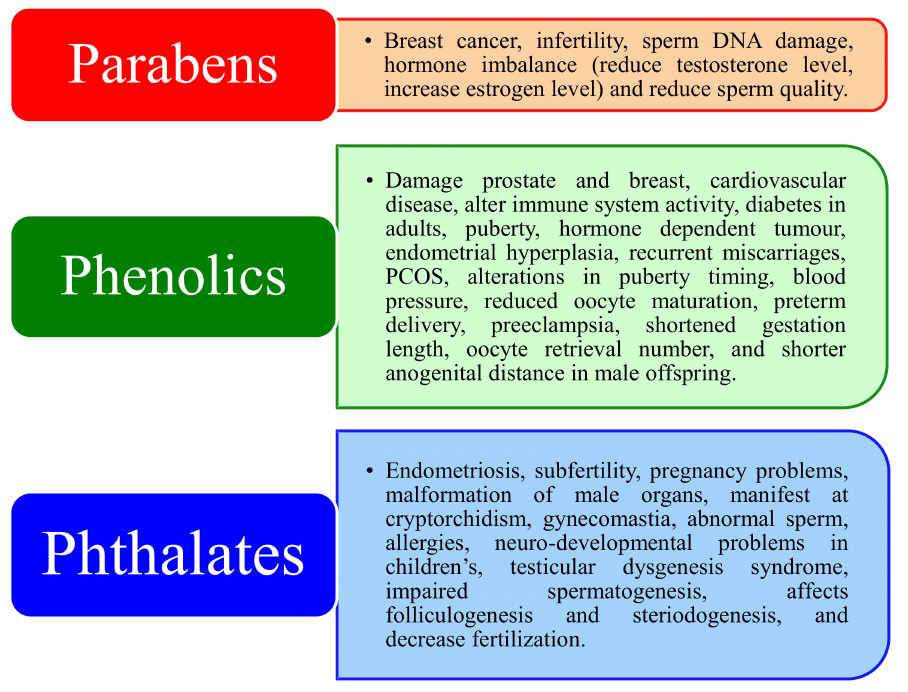
Figure 4. Human health effects of